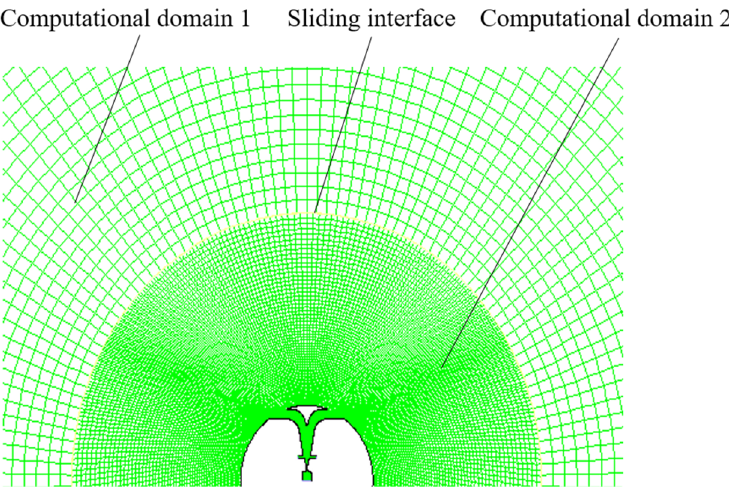
Figure 7. Internal and external flow field grid.